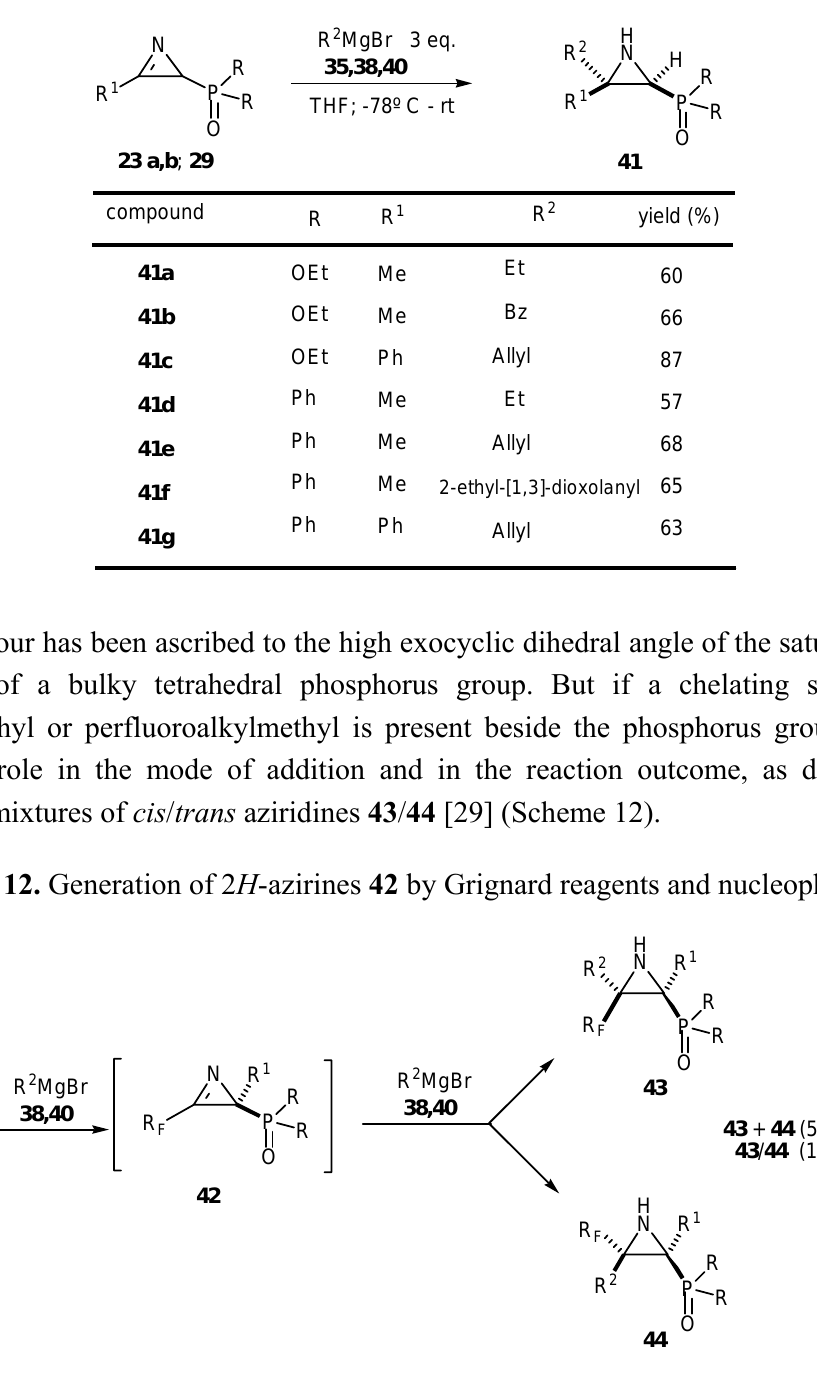
Table 1. Addition of Grignard